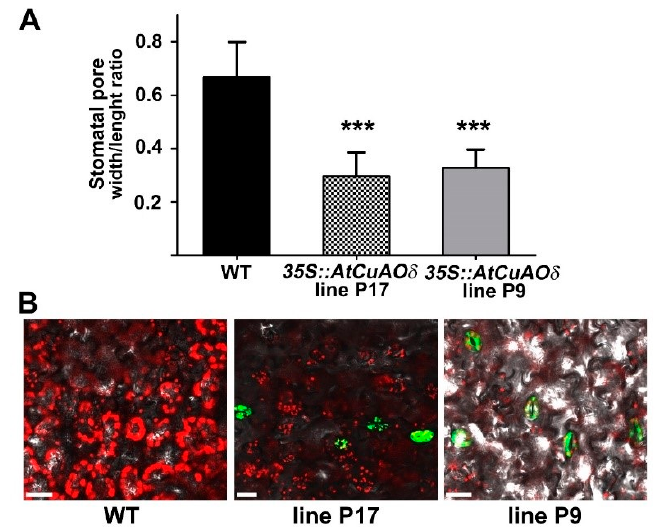
Figure 4. E ff ect of AtCuAO δ over-expression on stomatal pore width / length ratio and ROS levels in guard cells of leaves from 12-day-old WT and overAtCuAO δ seedlings. ( A ) Leaves from WT and overAtCuAO δ lines P17 and P9 were incubated in the opening solution for 3 h under light to allow stomata opening and then incubated with the fixing solution. Then, the width / length stomatal ratio was measured. Mean values ± SD ( n = 15) are reported. The significance levels between WT and overAtCuAO δ plants are reported. P values have been calculated with one-way ANOVA analysis; ***, p value equal or less than 0.001. ( B ) In situ ROS detection in guard cells by LSCM analysis after CM-H 2 DCFDA staining (green-yellow) of leaves from WT and overAtCuAO δ lines (P17 and P9). Micrographs are representative of those obtained from five independent experiments, each time analyzing leaves from five plants per genotype and treatment. Bar = 25 µm.